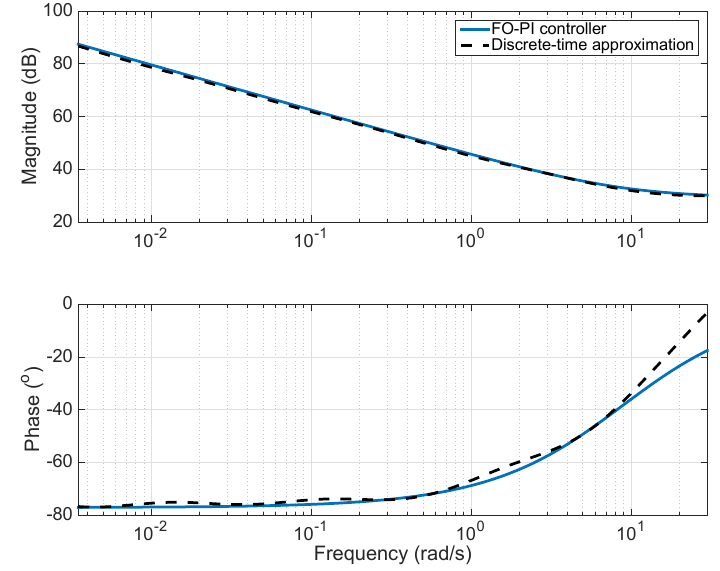
Figure 4. Frequency response of the FO-PI controller and its discrete-time approximation.